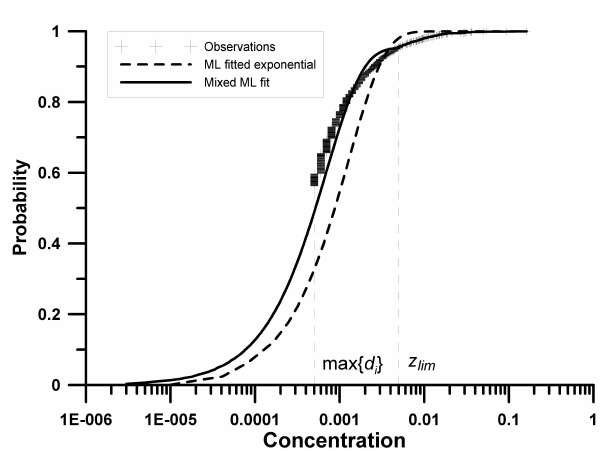
Fig. 2. The distribution of chloride concentrations and the estimated distributions corresponding to different degrees of